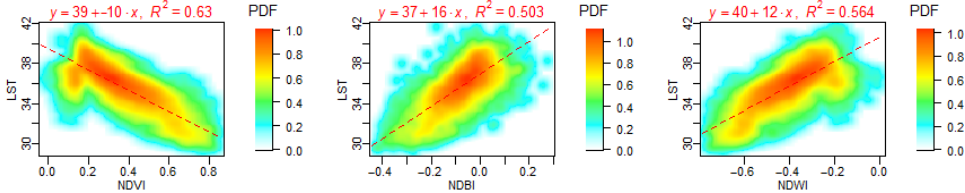
Figure 5. Scatter plots showing correlations between spectral indices and LST derived from Landsat 8 satellite.